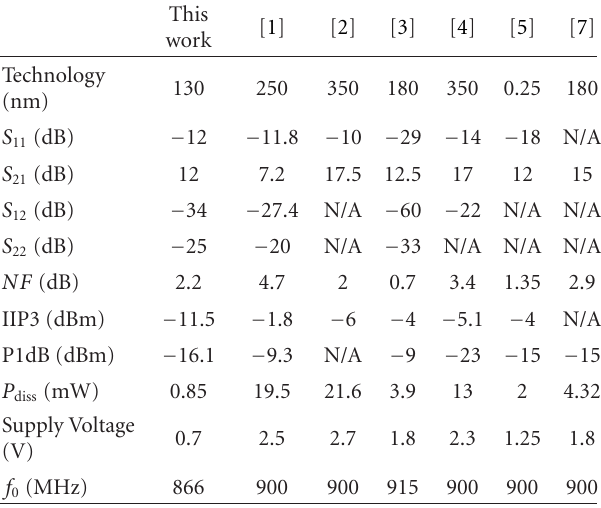
Table 1: Summary of the 866MHz UHF RFID LNA performance and comparison with previous UHF LNA